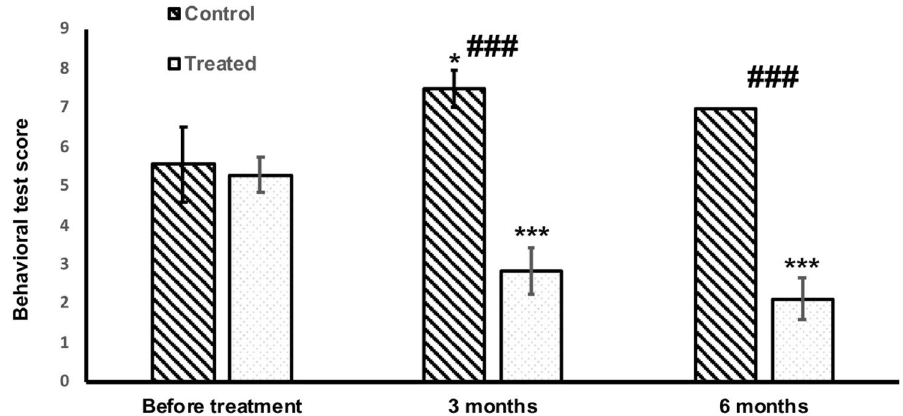
Figure 3. Problem-solving tests score before and during the treatment in treated and untreated groups. At the beginning of the study, there was no significant difference between treated and untreated dogs. In untreated dogs, the problem-solving task was significantly worse after 3 months (*, p < 0.05), while in the treated group, there was a significant improvement at both 3 and 6 months (***, p < 0.001). There was a statistically significant difference between treated and untreated groups at both 3 and 6 months (###, p <